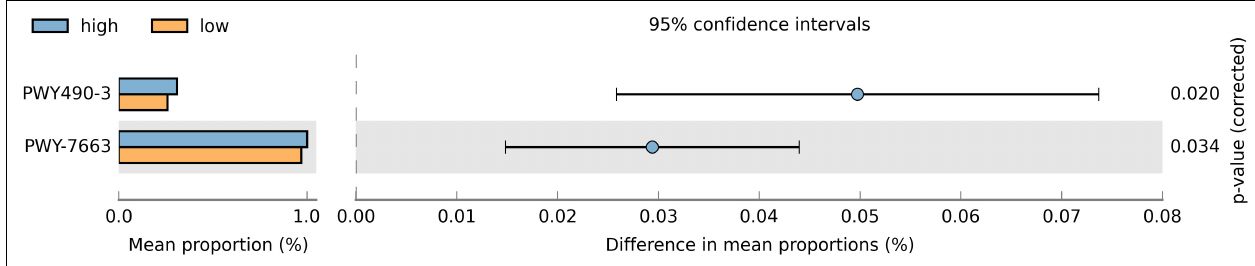
FIGURE 3 | Proportions of differentially active metabolic pathways between children with a low and high sweet treat consumption. Metabolic pathways were predicted using PICRUSt2 and analyzed with STAMP. Differences in mean proportions are shown with 95% confidence intervals. Results based on Welch’s test, p -values using the Bonferroni correction. Only pathways with adjusted p -value < 0.05 are shown. PWY490-3 = nitrate reduction IV (assimilatory), PWY-7663 = gondoate biosynthesis (anaerobic) from MetaCyc